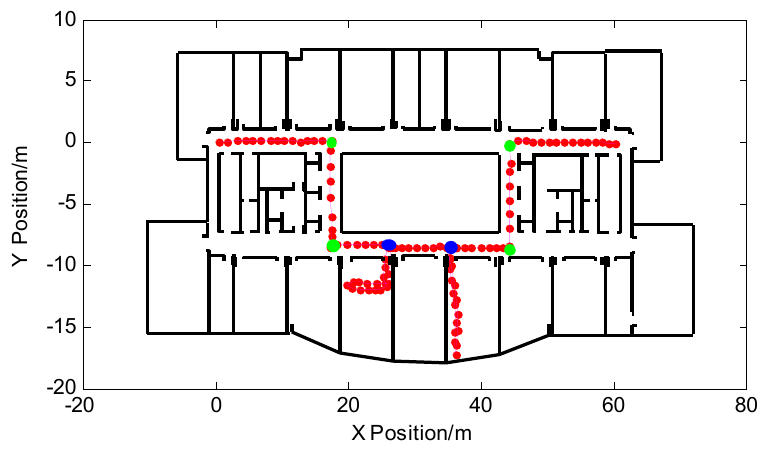
Figure 17. Pedestrian trajectory after correction. Table 1. Comparison of parameters before and after correction of the algorithm. Parameters Experiment 1 Experiment 2 Before